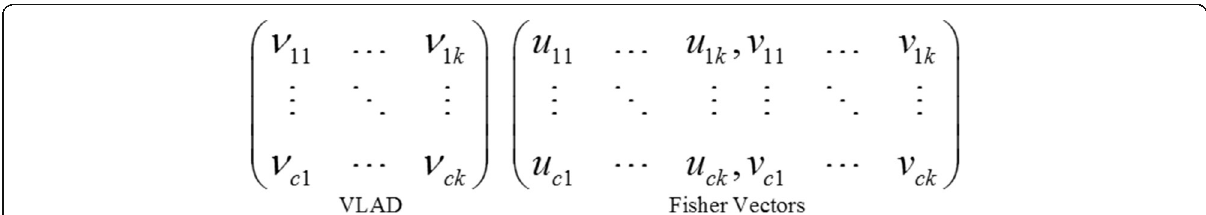
Fig. 4 Comparison of distribution of data on VLAD, Fisher Vectors where c , k denote number of channels, number of centers of K-means, or GMM,